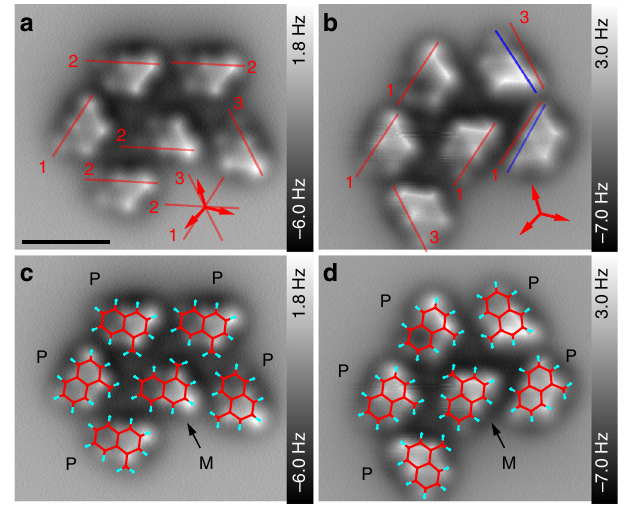
Fig. 6 Constant height AFM scans of a molecular cluster consisting of [123] tetramantane. a Scan before manipulation by AFM tip. b Scan after manipulation by AFM tip. The numbered red lines indicate the three main directions of molecular alignment. The three red arrows indicate the crystallographic [0 – 11], [10 – 1], and [ – 110] directions. The two blue lines in b indicate molecules that were not rotated by inter multiples of 60°. c , d AFM scans overlaid with molecular structures. The cluster contains fi ve ( P )-enantiomers and one ( M )-enantiomer. For clarity only the plane containing the two speci fi c hydrogens is plotted (see Fig. 4). Scale bar: 1